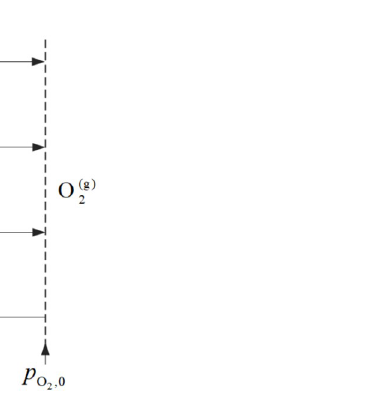
Fig 2. General diffusion model for the growth of a three-layered oxide structure.